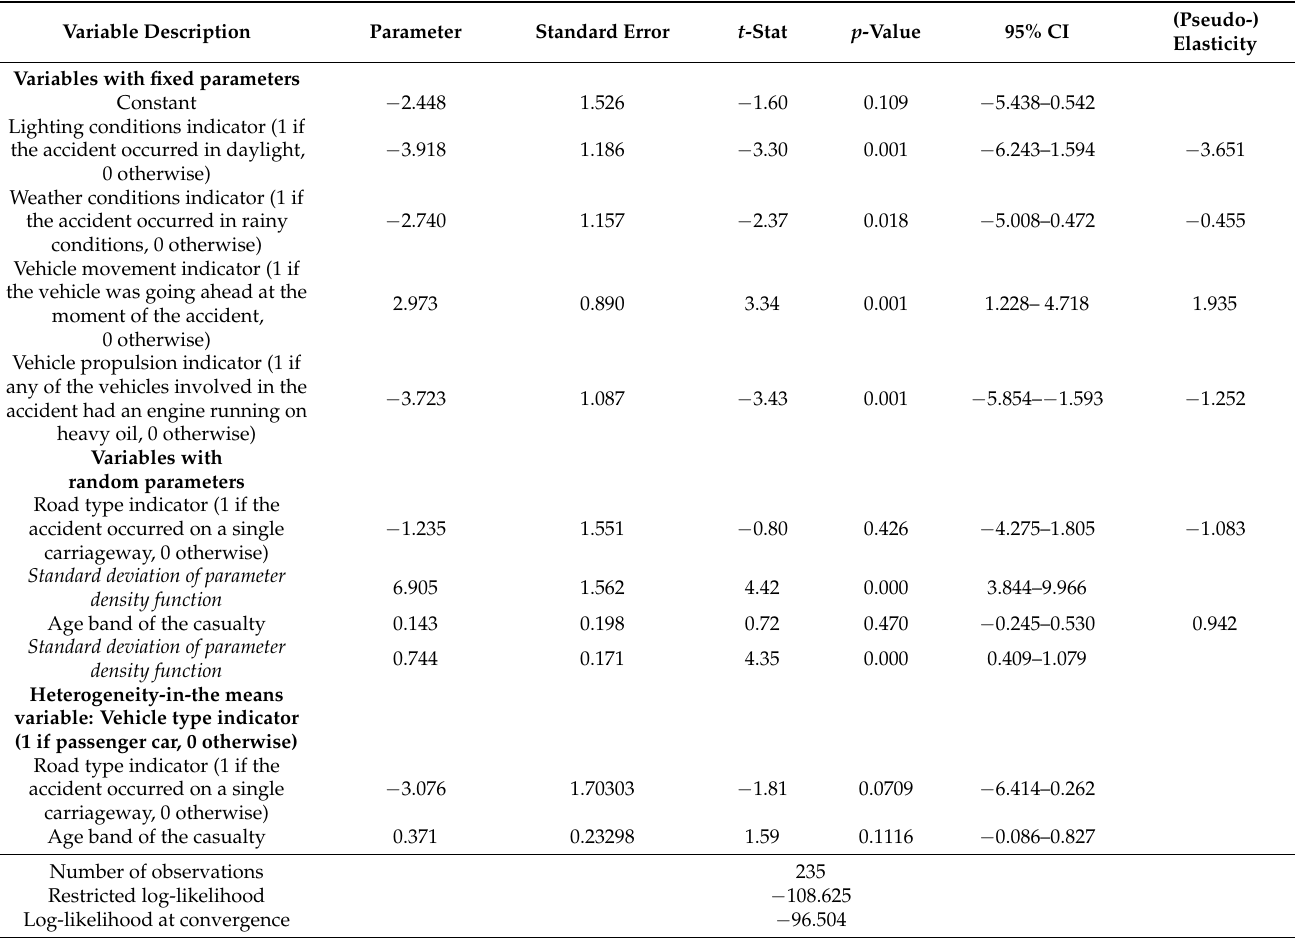
Table 4. Estimation model for school travel-related accidents in rural